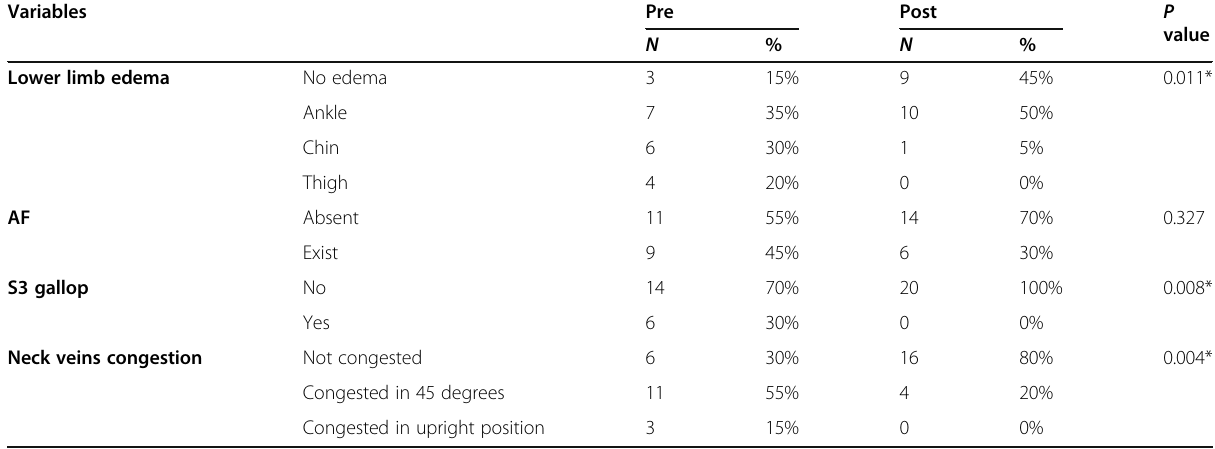
Table 3 Paired comparisons pre- and post-mitral clipping for right-side heart failure manifestation Variables